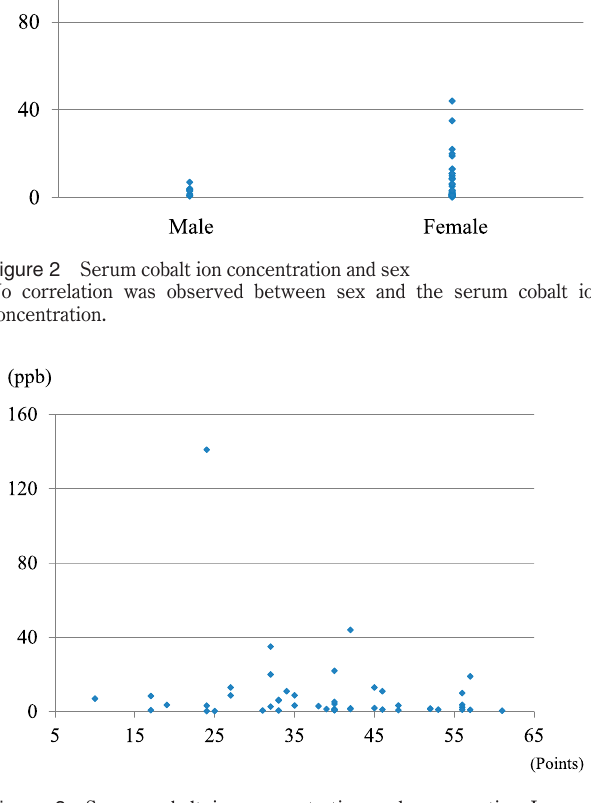
Figure 3 Serum cobalt ion concentration and preoperative Japanese Orthopaedic Association (JOA) hip score The mean preoperative JOA hip score was 38.8 points (standard deviation, 12.1), and no correlation was observed with the serum cobalt ion concentration.